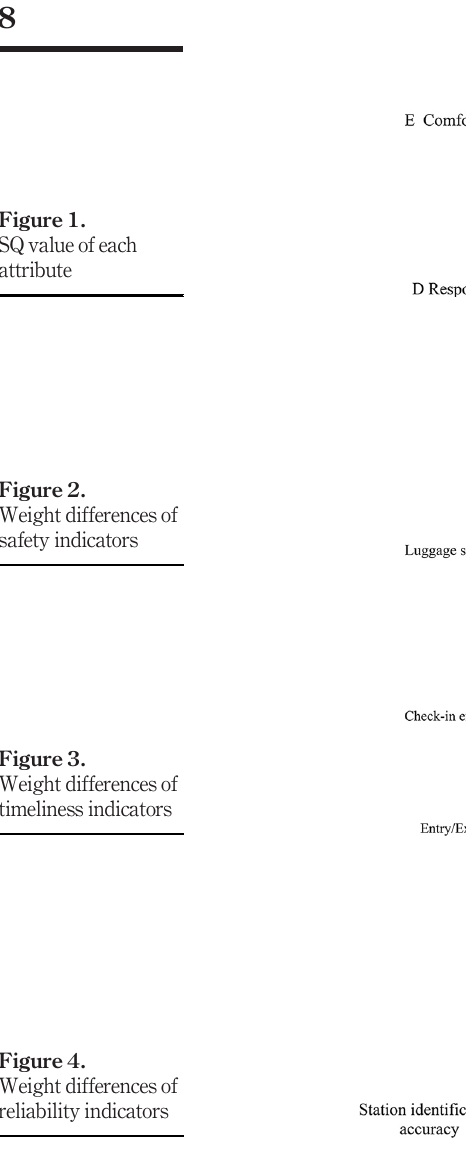
Figure 1. SQ value of each